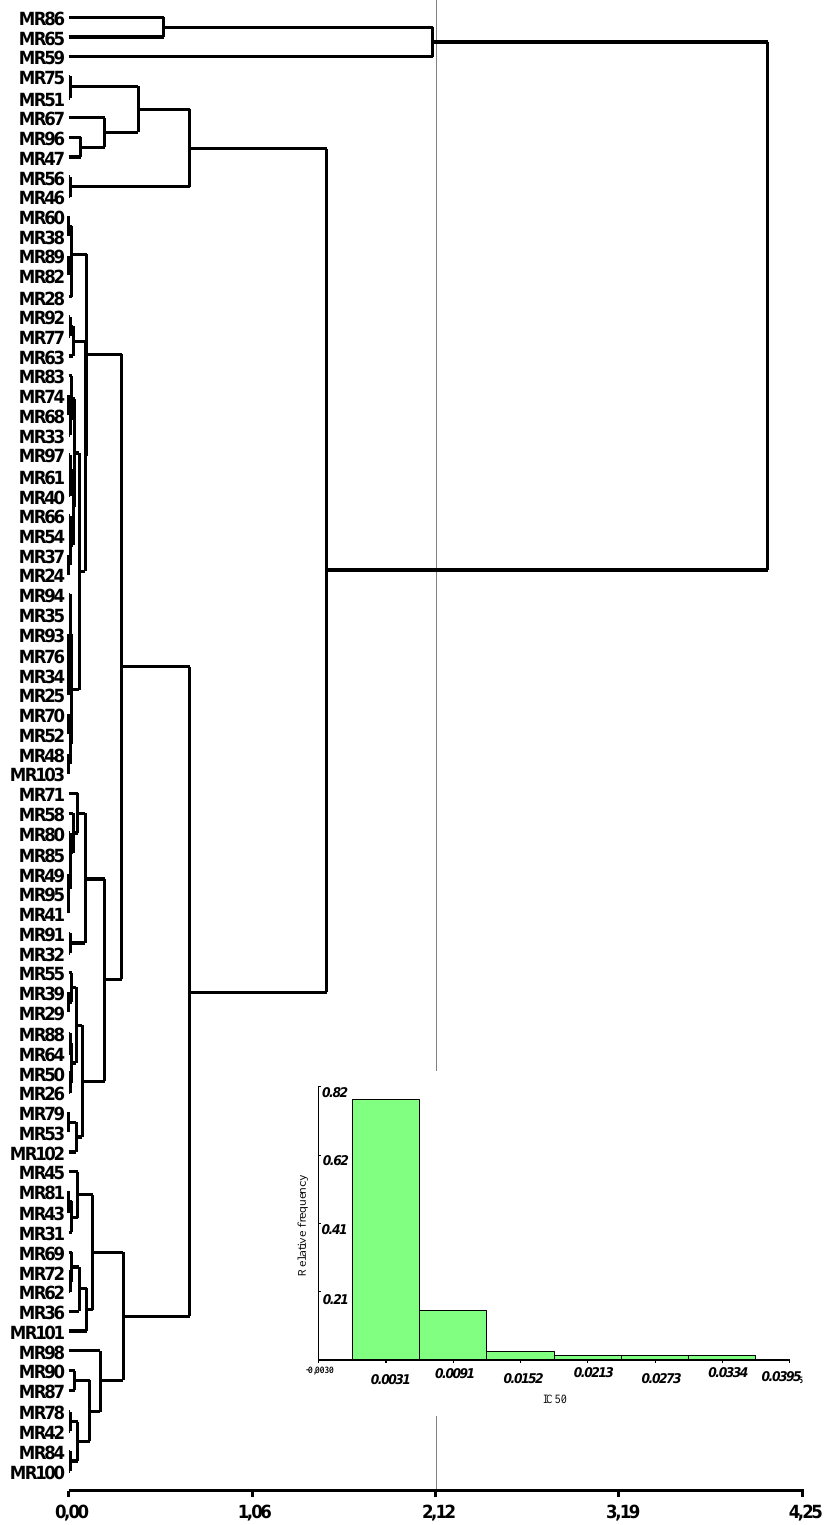
0,00 1,06 2,12 Figure 2. Dendrogram shows two groups of 71 M. roreri isolates according to the IC 50 s values of azoxystrobin (cophenetic correlation 0.930). Ranges of the observed IC 50 and the No. of isolates in each group (respectively) were: more sensitive 0.0000–0.0146 µ g mL − 1 (68) and less sensitive 0.0220–0.0364 µ g mL − 1 (3). Histogram shows the relative frequencies according to the IC 50 s. The IC 50 values were low for all isolates against azoxystrobin (Figure 2, Supplemen- tary Table S1). The maximum IC 50 observed was 0.0364 µg mL −1 (Figure 2, histogram), indicating a high sensitivity to this molecule in the Ecuadorian samples. This behavior was widespread among most samples, as shown the branch including most isolates in the dendrogram (Figure 2). No significant differences were observed between the IC 50 values when separating the populations of the Amazon and the Pacific coast (data not shown). Despite observing low IC 50 values for most isolates, three differed from the rest be- cause they were less sensitive with values from 0.0220 to 0.0364 µg mL −1 (Figure 2, small